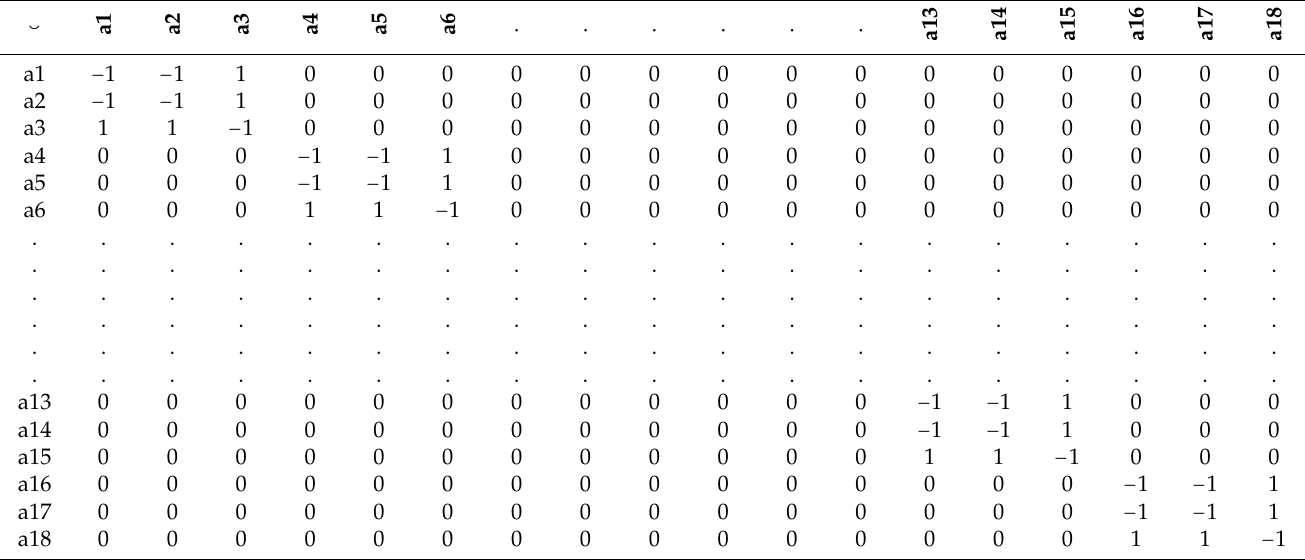
Table A5. Cup product of the cocycles deduced from the homeomorphic representation of Figure 21 (CC).